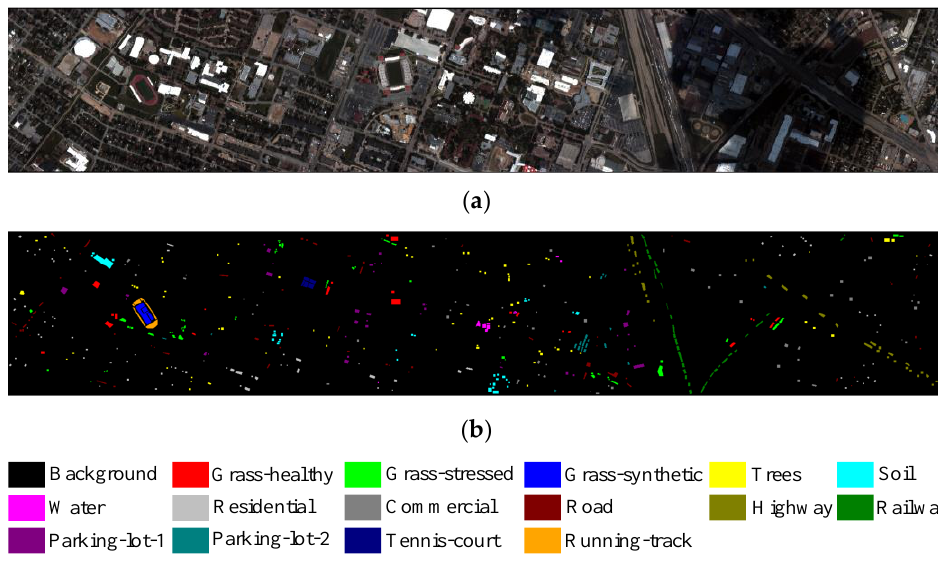
Figure 8. Houston dataset: ( a ) false color map, ( b ) ground truth. Table 3. Land cover classes and numbers of samples in the Houston dataset.